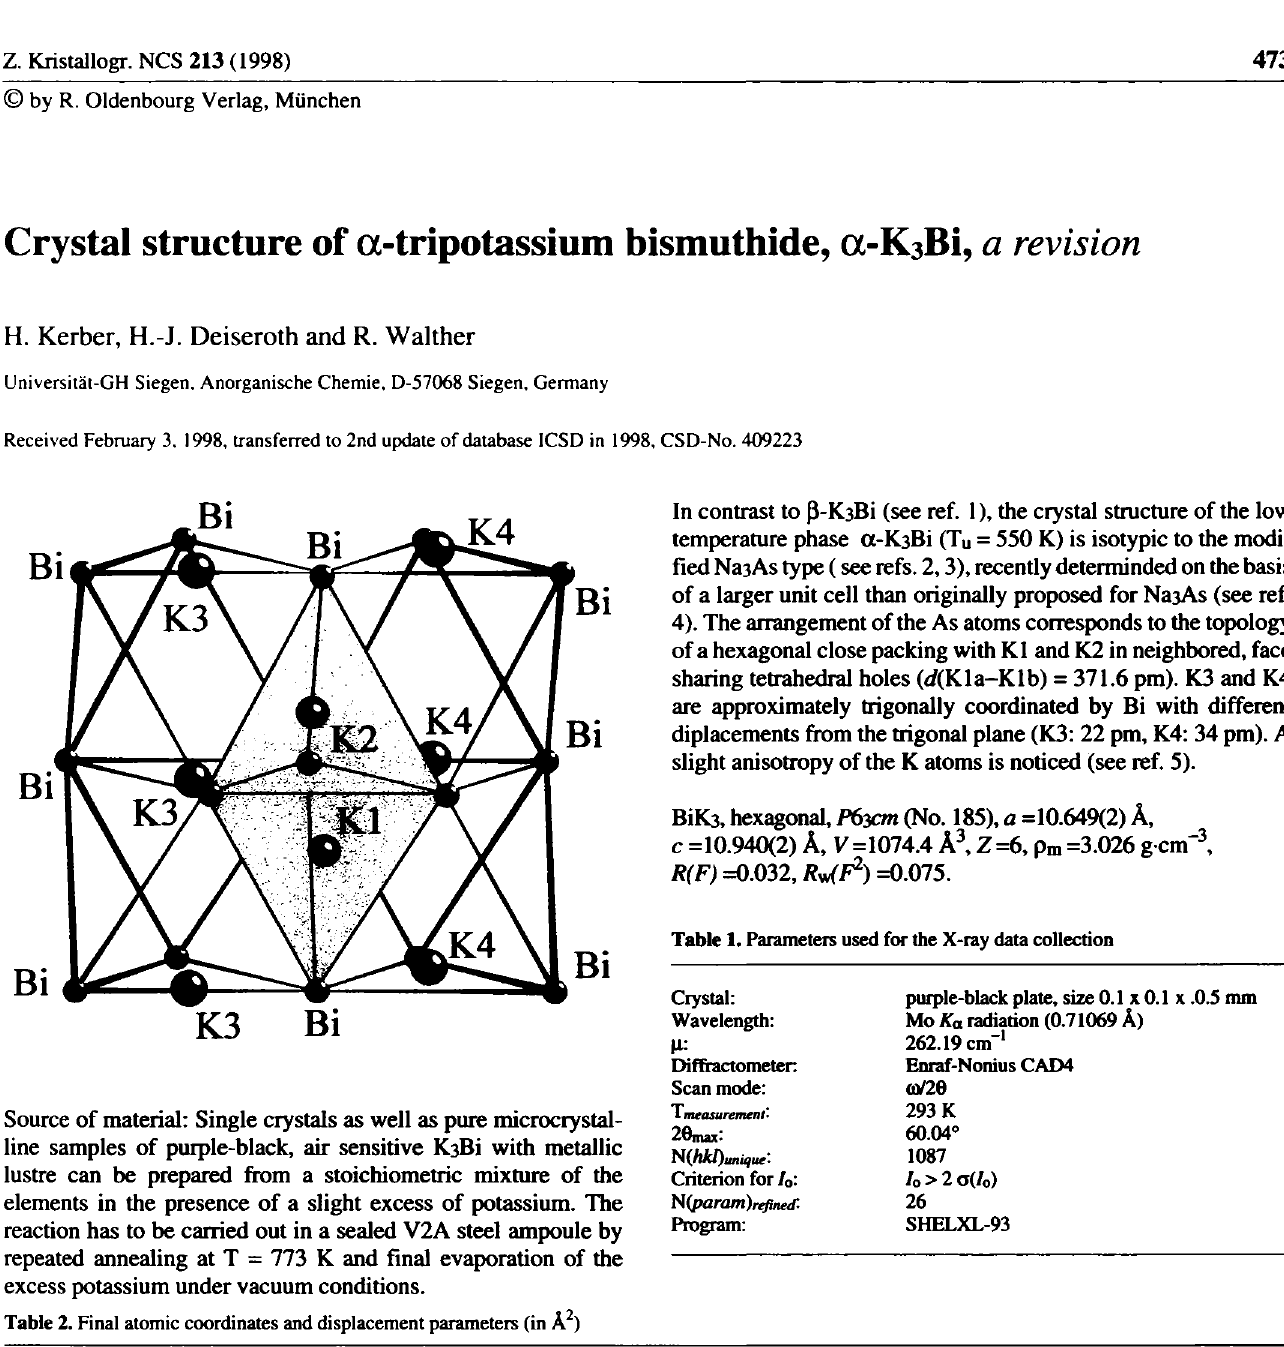
Table 2. Final atomic coordinates and displacement parameters (in